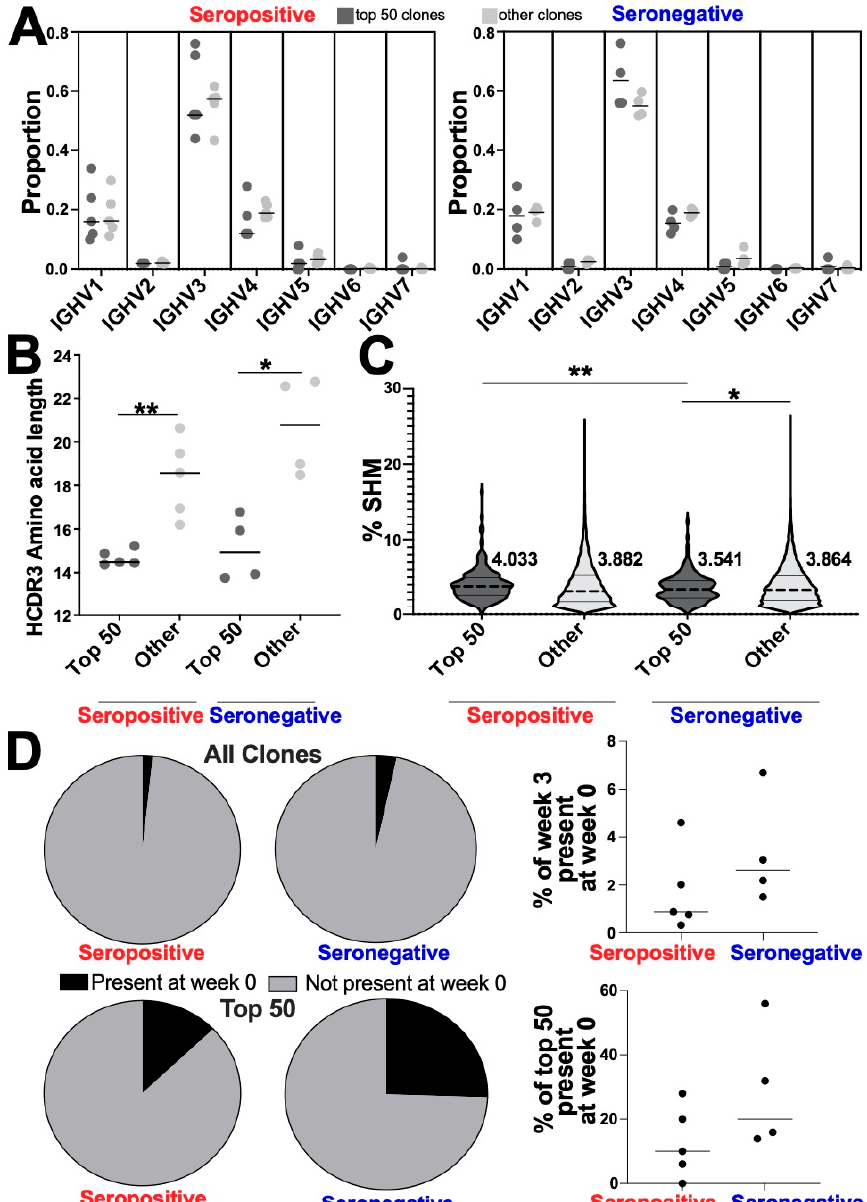
Figure 4. Characteristics of expanded “top 50” IgG clonotypes in seropositive and seronegative individuals after one dose of Comirnaty ® (Pfizer, New York, NY, USA). ( A ) IGHV gene usage plotted for top 50 IgG clonotypes compared to the remaining clones in the repertoires of seropositive (left) and seronegative (right) individuals at week 3. No differences were observed in the V gene usage patterns between the clone groups (top 50 v. other) in either serotype. ( B ) Top 50 IgG clones’ HCDR3 length was shorter than “other” (the remaining clonotypes) for both seropositive and seronegative (Mann–Whitney test ** p = 0.0079, * p = 0.0286). No difference in top 50 HCDR3 length was observed between serotypes. ( C ) Violin plots depicting percentage SHM for top 50 IgG clones and other based on serotype, strong dashed line indicates mean value, fine dashed line indicates quartile, means are to the right of each violin. (Welch’s t -test; ** p = 0.0080, * p = 0.0123). ( D ) Pie charts depicting the proportion of IgG clones that were present at week 0 (black) and novel at week 3 (gray) for the entire repertoire (top) or just top 50 (bottom). Serotype indicated under pie charts. Right panel, plots depicting individual proportions of clones present at week 0 for the whole repertoire (top) and top 50 (bottom). No statistical differences were observed between serotypes.